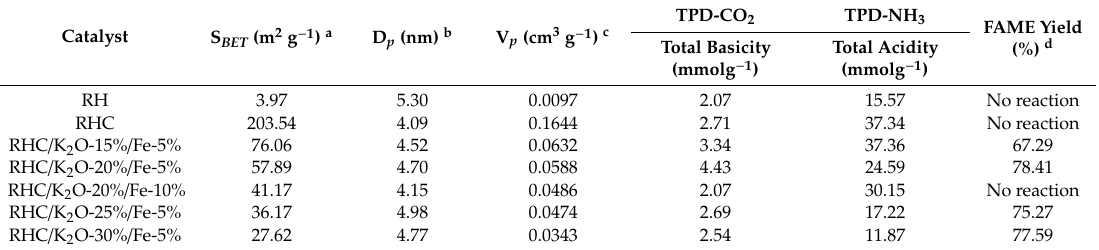
Table 1. Textural properties and total desorption of CO 2 and NH 3 for RH, RHC, and RHC / K 2 O /